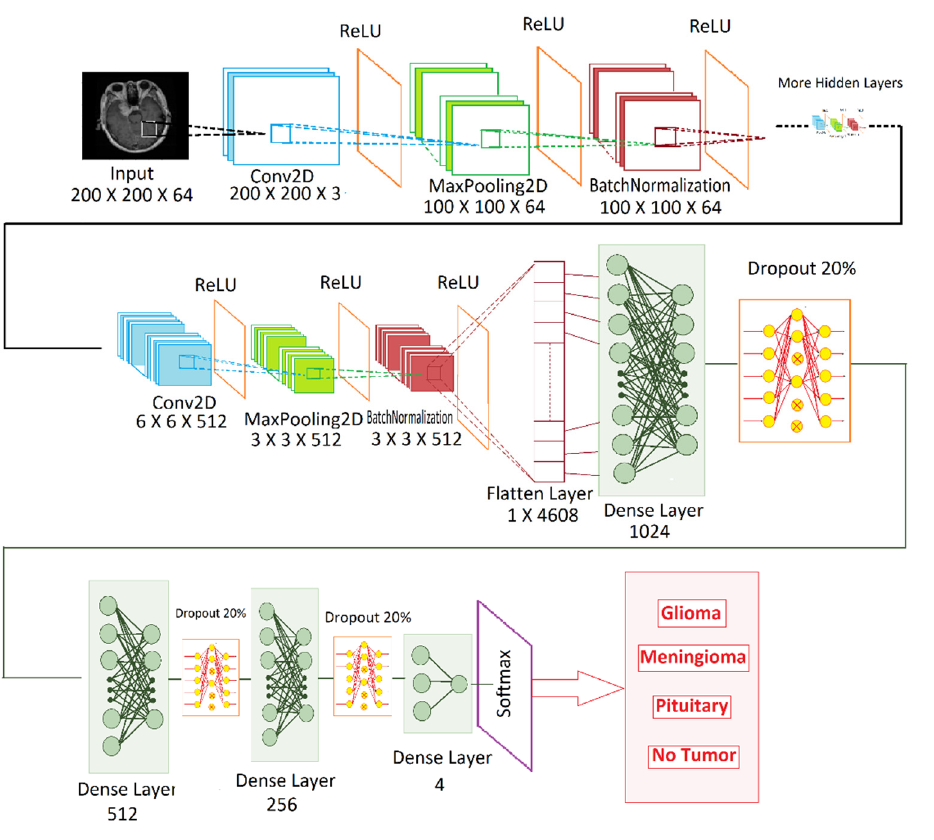
Figure 3. The modified VGG-16 model.